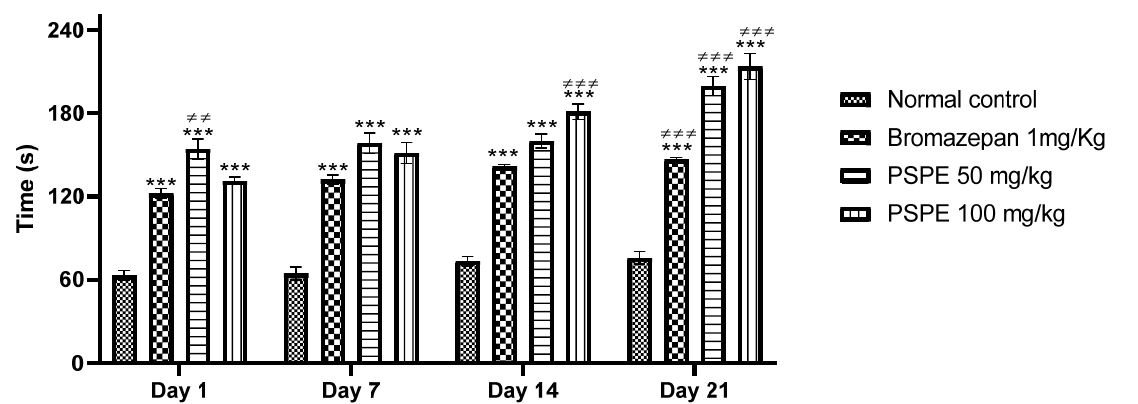
Figure 6. Variation in time spent in the lighted chamber during the three weeks of treatment in control and treated mice (*** p ≤ 0.001 in comparison to negative controls, ≠≠ p ≤ 0.01 and ≠≠≠ p ≤ 0.001 in comparison to positive controls). PSPE: Polyphenolic fraction of P. sativum.